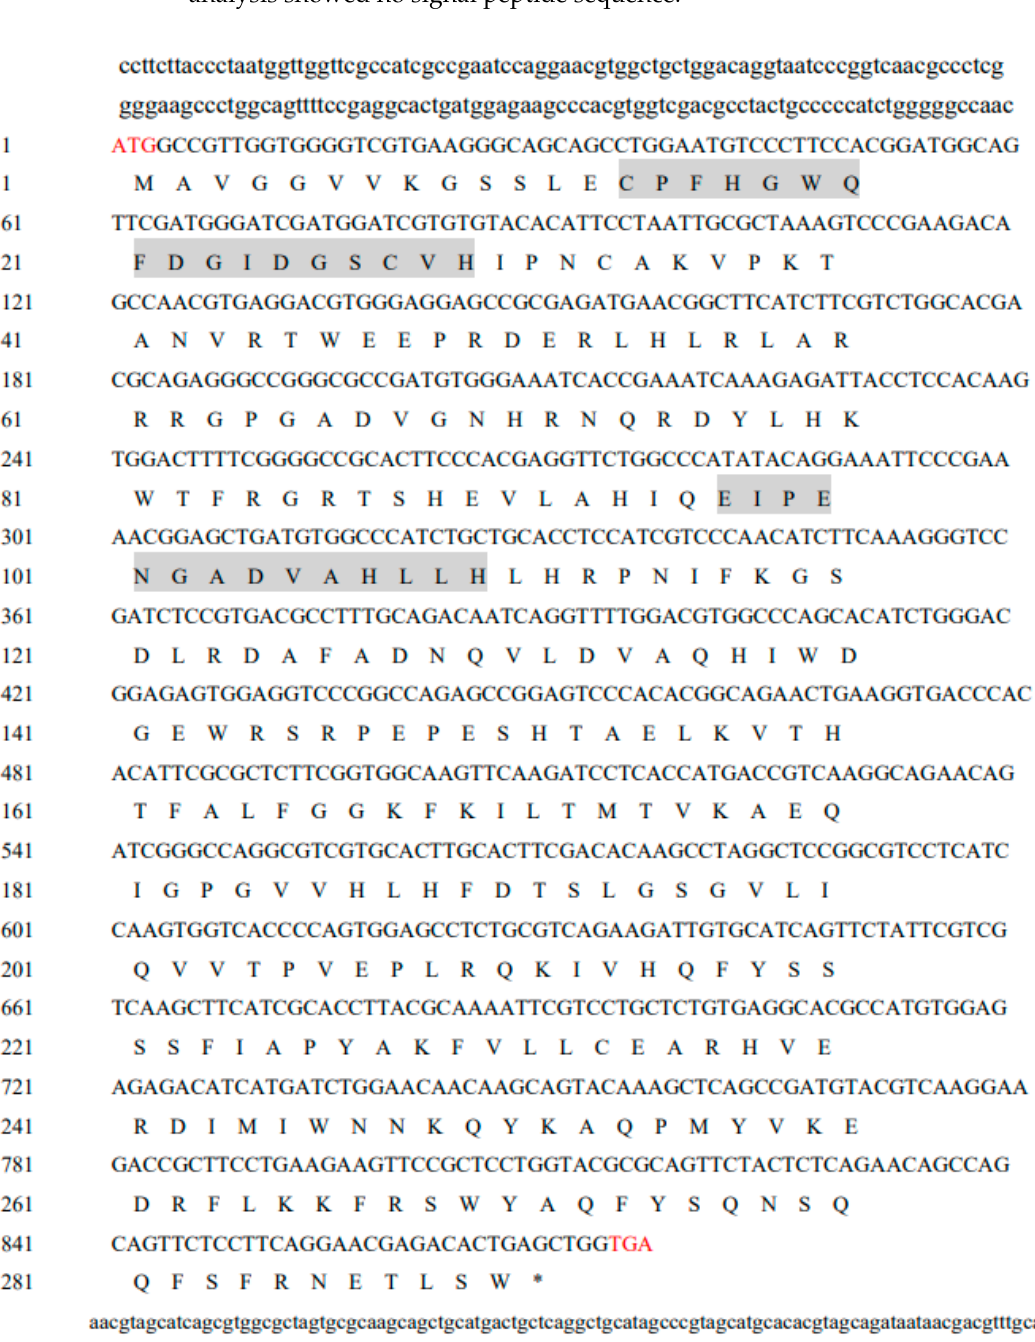
Figure 1. Full cDNA sequence and predicted amino acid sequence of Mn-CH7D . The start codon ATG and the stop codon TAG are marked with red. The gray shades are two conserved domains, in order: the Rieske [2Fe-2S] domain and the non-heme iron binding domain. The black box represents the tailing signal and poly(A). The stop codon TAG in the amino acid sequence is represented by an asterisk (*).